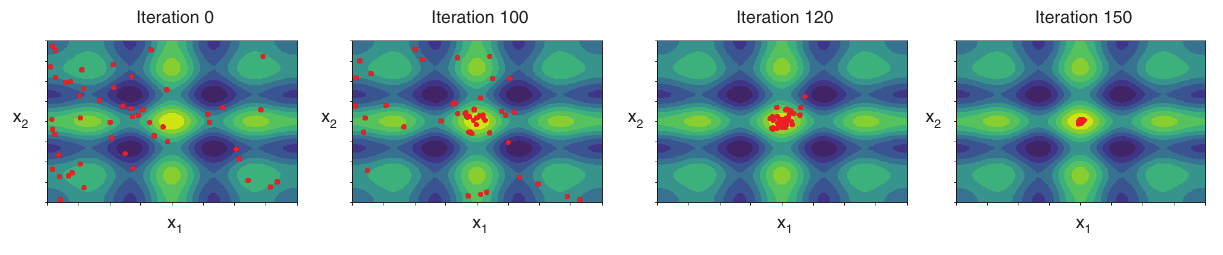
Figure 3: Results from a toy model test. Samples generated from the generator, shown as red dots, evolve in the [−1, 1] 2 space over the course of